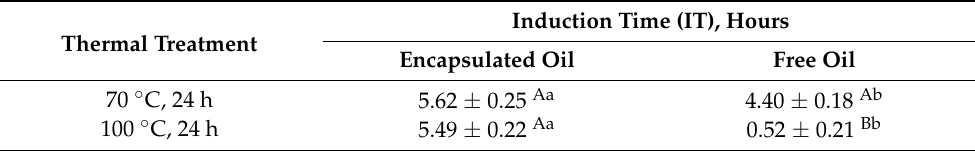
Table 2. Effect of thermal treatment in oxidative stability of encapsulated and free cod liver oil. Thermal Treatment